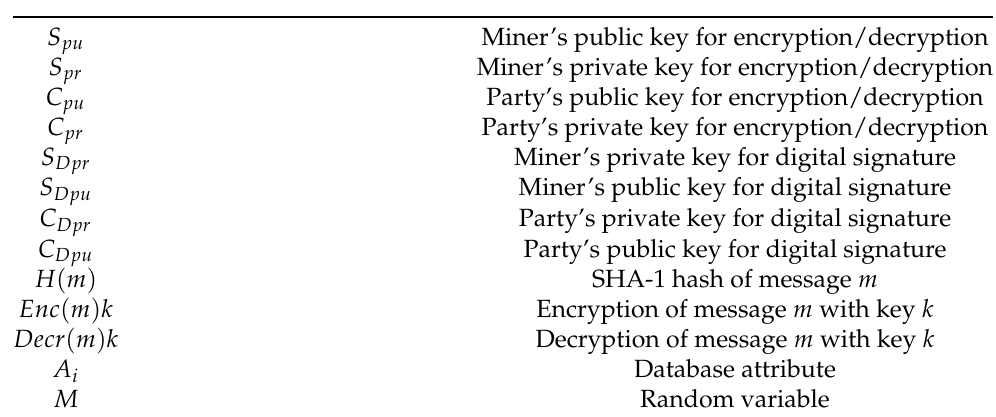
Table 2. Protocol